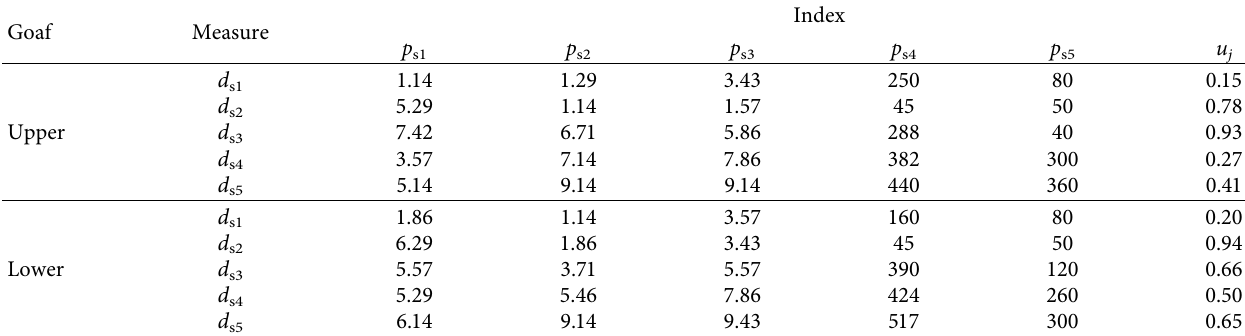
Table 3: Te index and the relative membership for goaf handling measures. Goaf